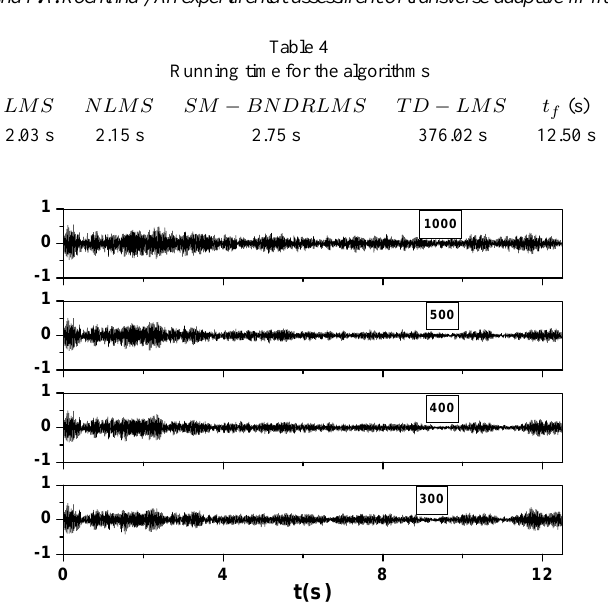
Fig. 26. Error function, in g units, based on the LMS algorithm for case C 6 for 300, 400, 500 and 1000 filter coefficients.